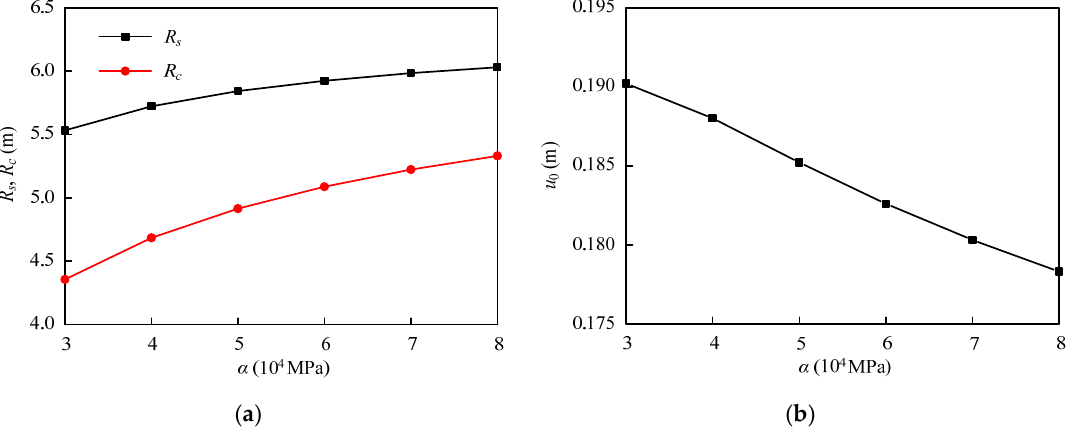
Figure 9. Effect of softening modulus coefficient of cohesion on the radii of strain-softening and crushed regions and surface displacement. ( a ) R s and R c ; ( b ) u 0 .